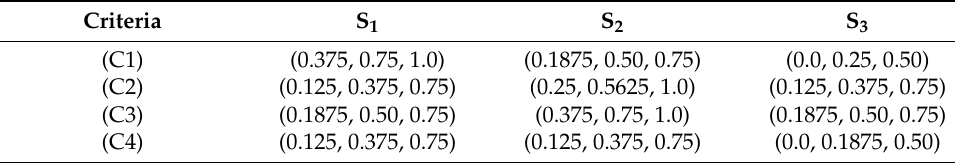
Table 9. Weighted and normalized supplier performance matrix.